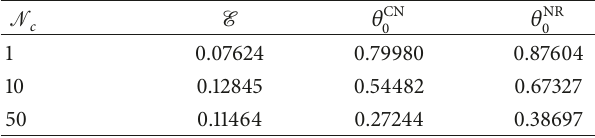
Table 2: Maximum error computed between the respective numer- ical solutions obtained, where E = max | CN sol − CN NR sol | , and their respective temperatures at the tip of the fin for varied values of N 𝑐